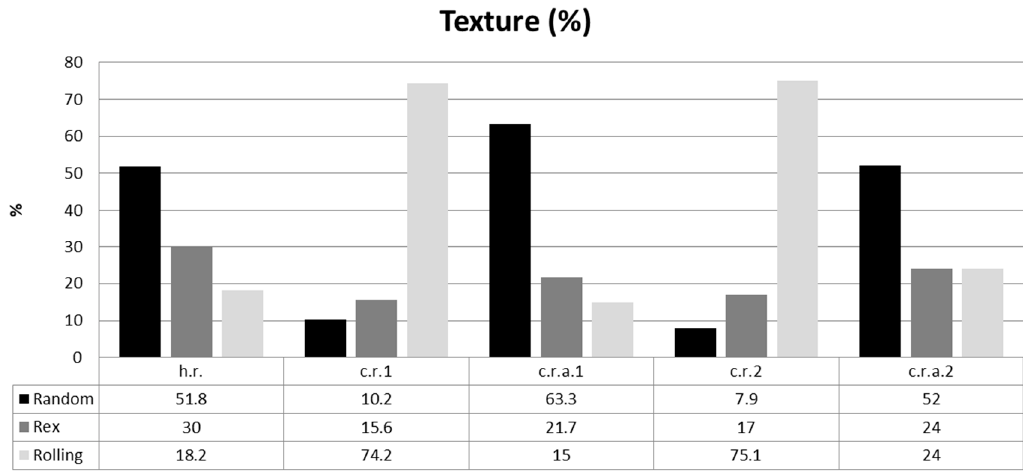
Figure 5. Texture percentage chart.